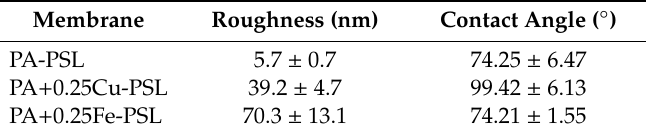
Table 1. Surface properties of the membranes.